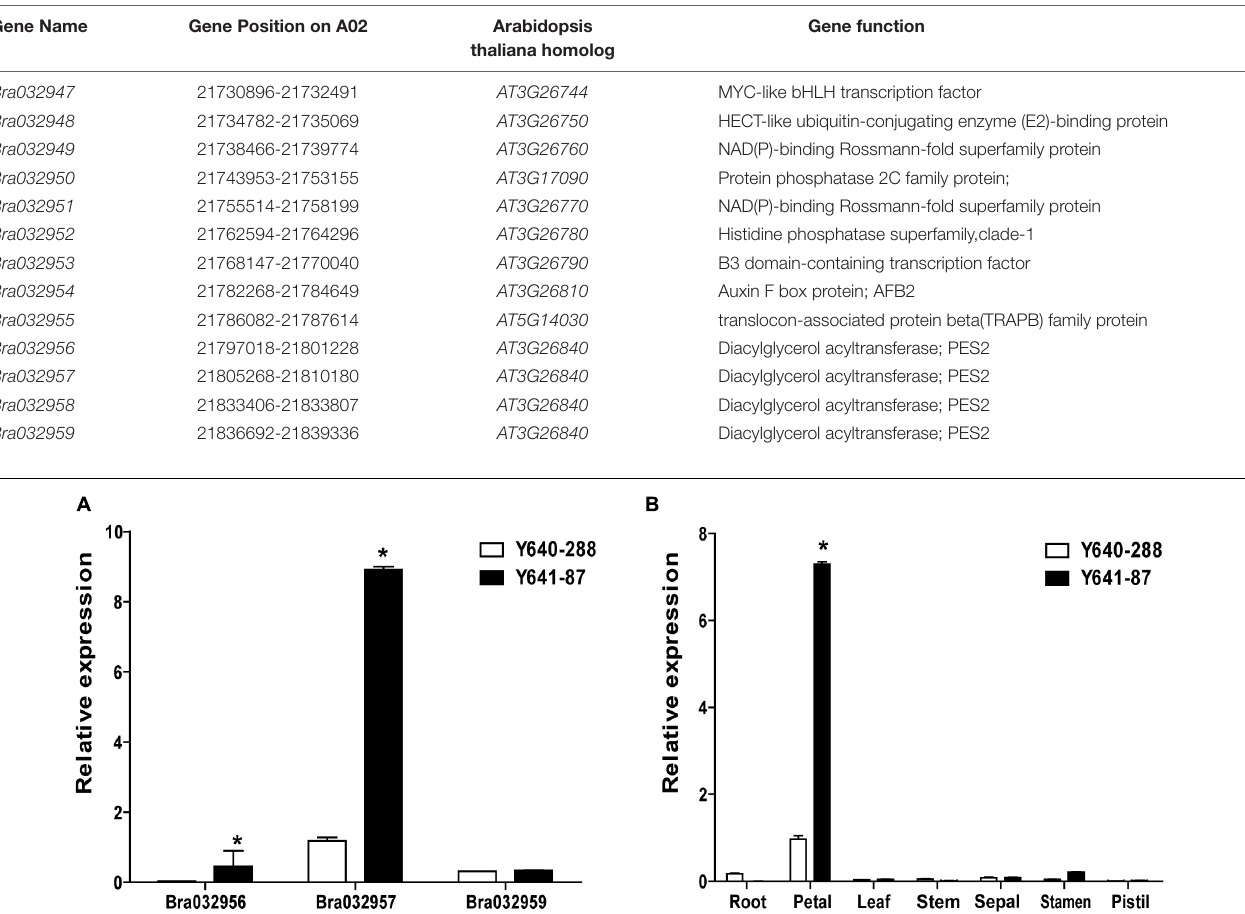
FIGURE 4 | Gene expression data analyses. (A) Relative expression of Bra032956 , Bra032957, and Bra032959 in petals of the two parents. (B) Relative expression of Bra032957 in different tissues of the two parents. Error bars represent the standard error of three biological replicates, and asterisks indicate significant differences ( t -test, p <